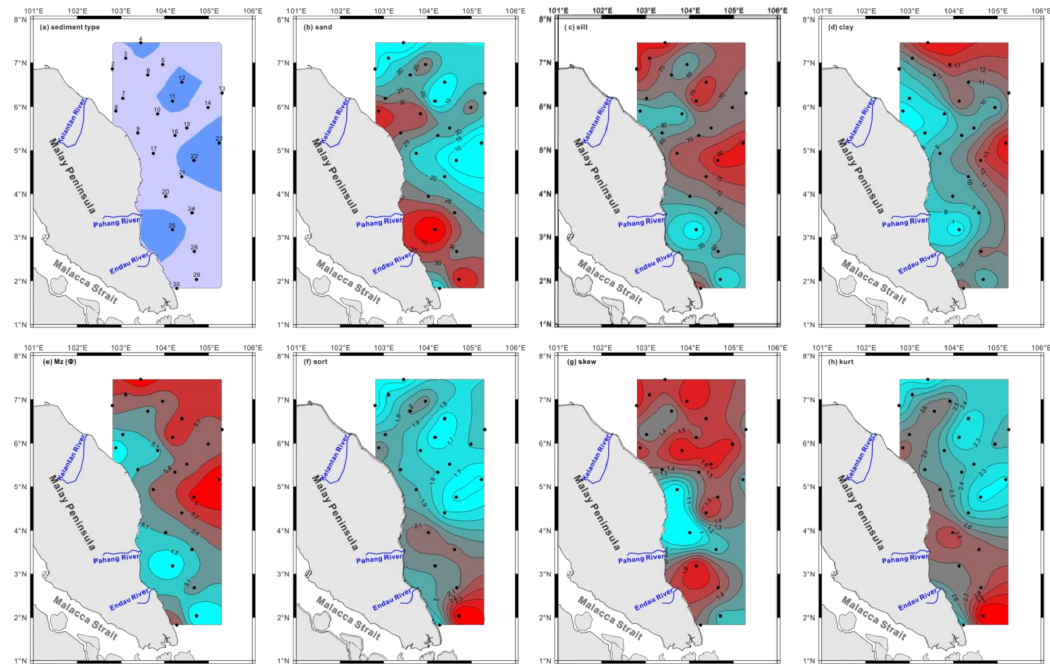
Figure 2. Locations of surface sediment samples (dark dots) used for grain size analyses on the western Sunda Shelf and the distribution of various grain size parameters in the study area. ( a ) Sediment type, ( b ) sand, ( c ) silt, ( d ) clay, ( e ) mean grain size (Mz, unit: Φ ), ( f ) sort (unit: Φ ), ( g ) skew, and ( h ) kurt. Dark and light blue indicate silts and sandy silts,